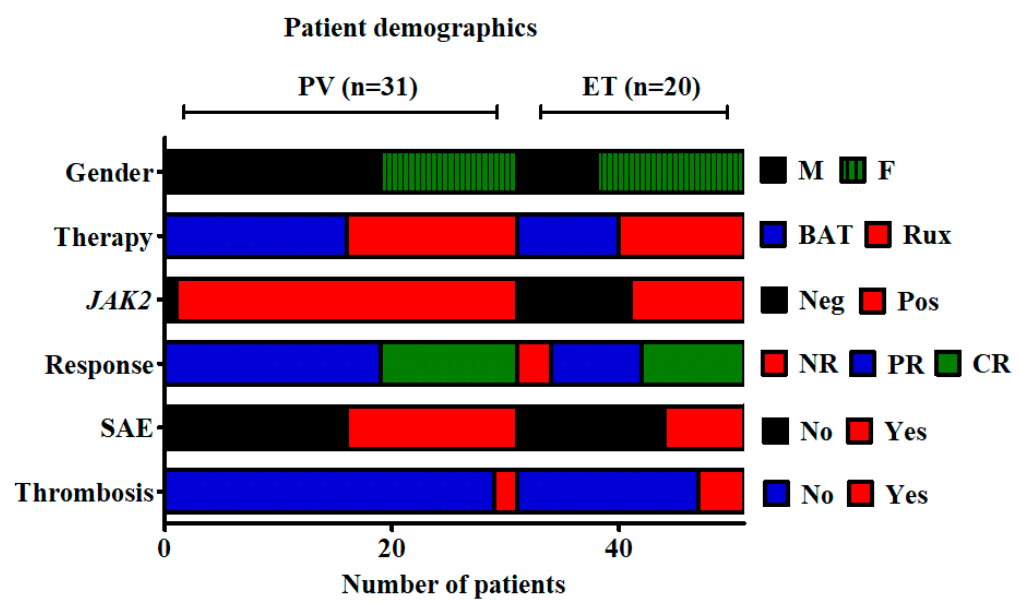
Figure 3. MAJIC patient demographics. Gender, treatment arm, JAK2 status, response status and incidence of serious adverse events (SAEs) and thrombosis per disease arm for the MAJIC cohort examined.